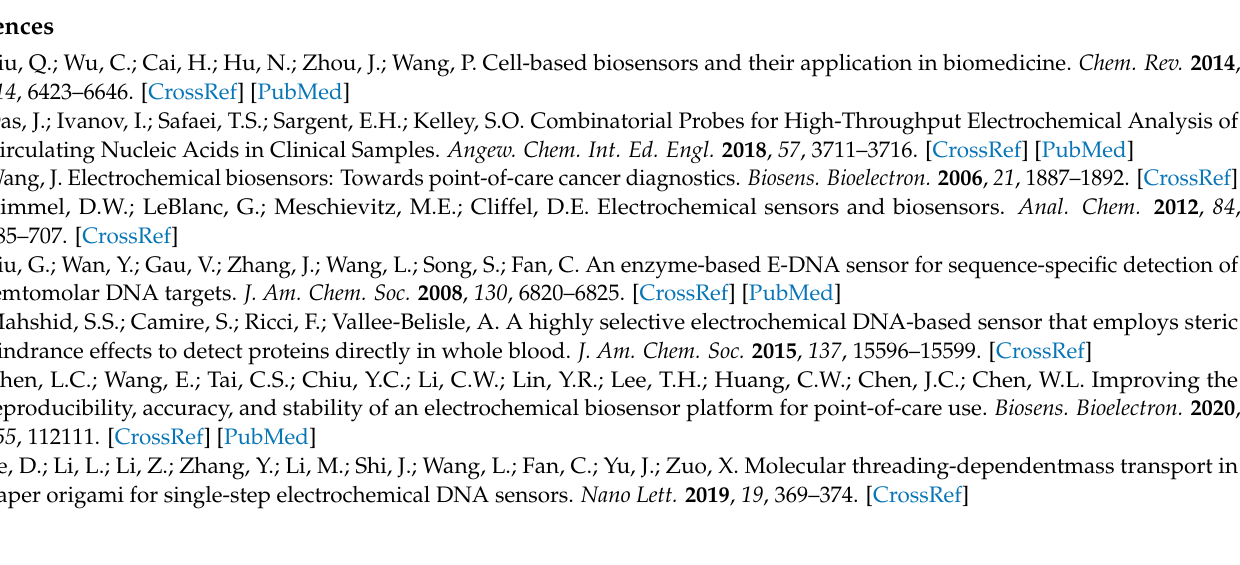
Figure S4: EIS curve of immobilization anti-HbA1c and APBA on BSA/MWCNTs/GA layer, Figure S5: Optimization of the experiment parameters in terms of (a) H 2 O 2 concentration; (b) pH; (c) Applied potential for catalytic H 2 O 2 reduction; (d) Temperature, Figure S6: Calibration curves for detection of HbA1c for anti-HbA1c-BSA/MWCNTs/GA